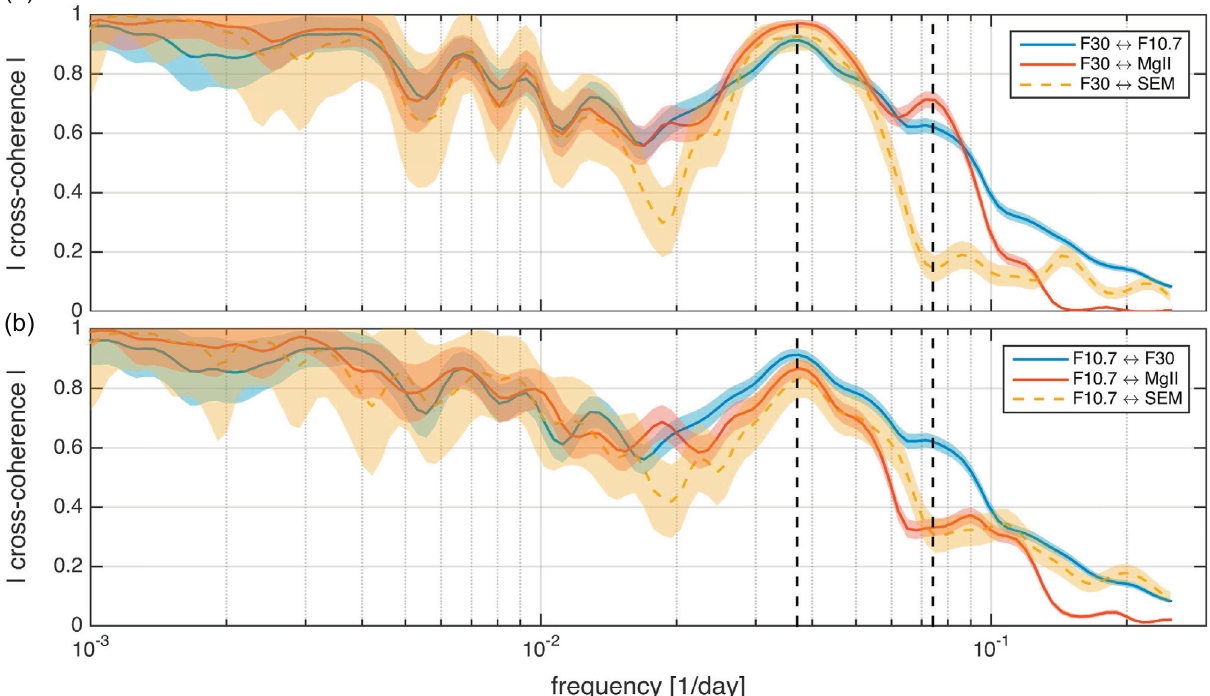
Fig. 5. Modulus of the cross-coherence between three proxies (F10.7, MgII and SEM) and F30 (a), and F10.7 (b). Coloured bands correspond to a ± r confidence interval. The 27-day and 13.5-day periods are indicated by dashed lines. The time intervals used for estimating the cross- coherence are proxy-dependent: solar cycles 20–24 for radio proxies, cycles 21–24 for the MgII index, and cycles 23 and 24 only for SEM. For that reason, the different cross-coherences are not strictly comparable.